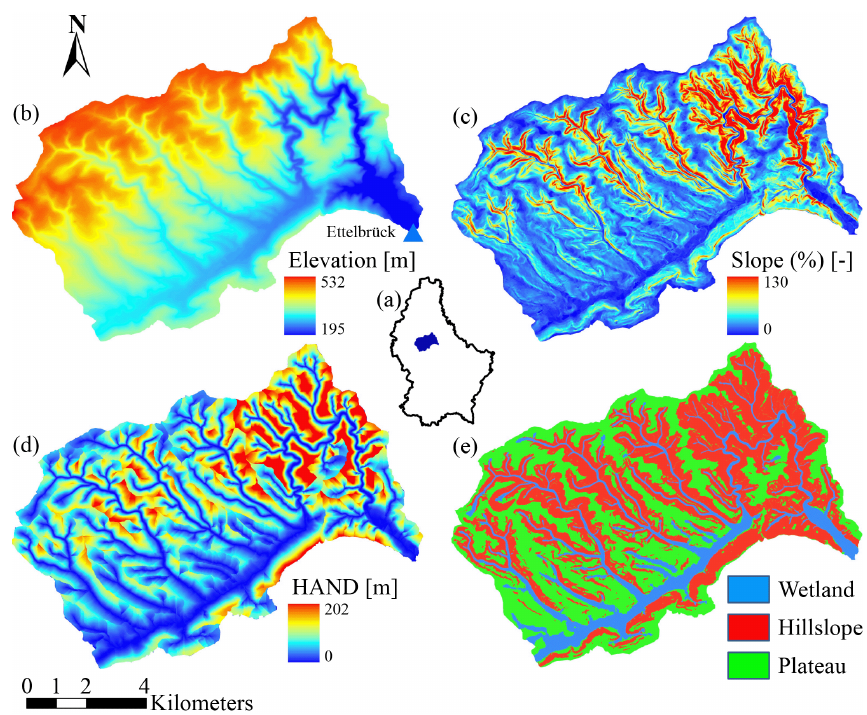
Figure 1. (a) Location of the Wark catchment in the Grand Duchy of Luxembourg, (b) digital elevation model (DEM) of the Wark catchment with cell size of 5m × 5m, (c) local slopes (%) in the Wark catchment derived from a DEM with resolution of 5m × 5m [–], (d) HAND of the Wark catchment derived from a DEM with resolution of 5m × 5m [m], (e) the classified landscape units wetland, hillslope and plateau using the combined HAND and slope thresholds of 5m and 11%, respectively (from Gharari et al.,